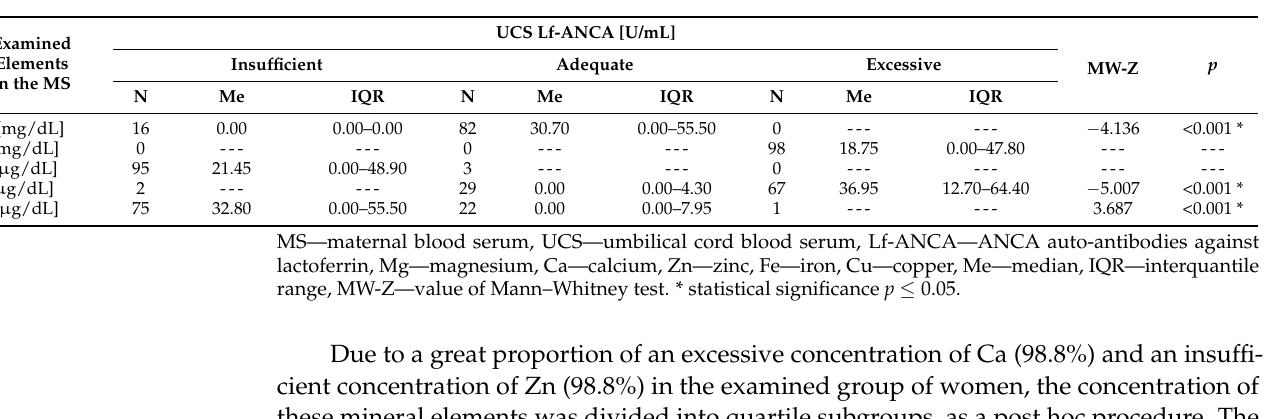
Table 6. The concentration of Lf-ANCA auto-antibodies in the UCS in relation to the concentration of macro- and microelements in the MS (insufficient, adequate and